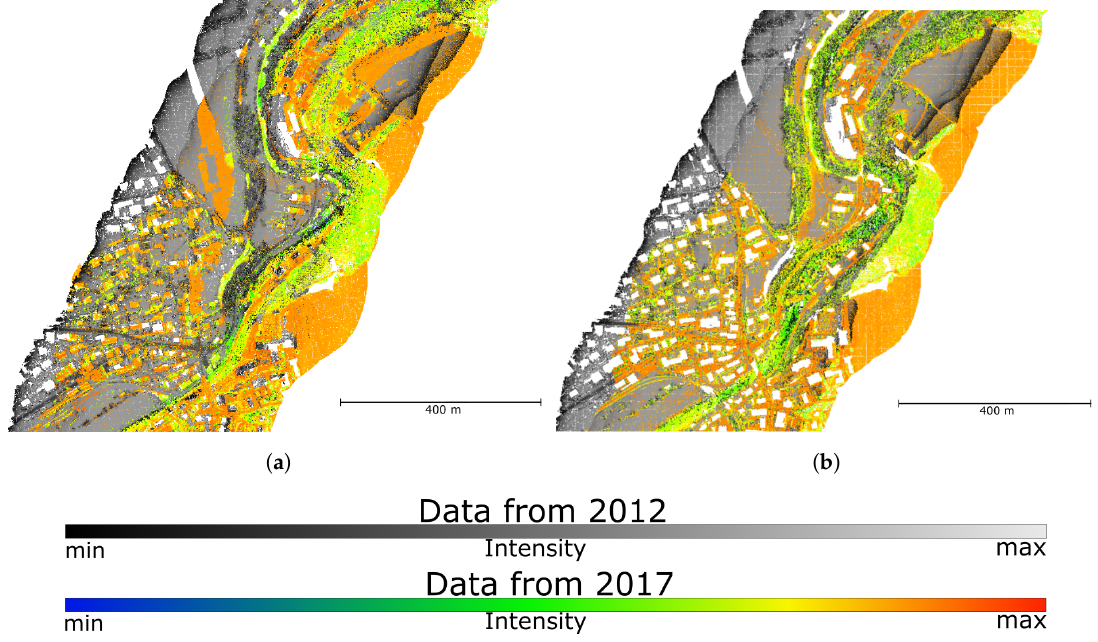
Figure 11. Comparison of the registration results using ICP and the proposed approach shown on the fourth scene. ( a ) Result of ICP. ( b ) Result of the proposed method. Shown data are the date of the whole flight strip downsampled to 1 m